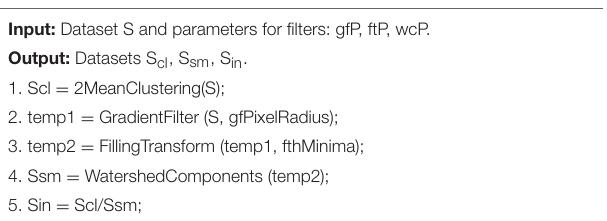
Algorithm 1: Preparing the